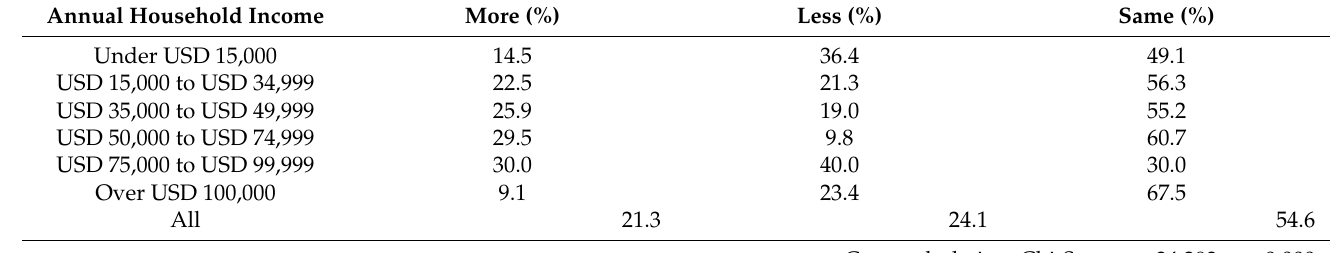
Table 9. Household Income and Future EIWA for